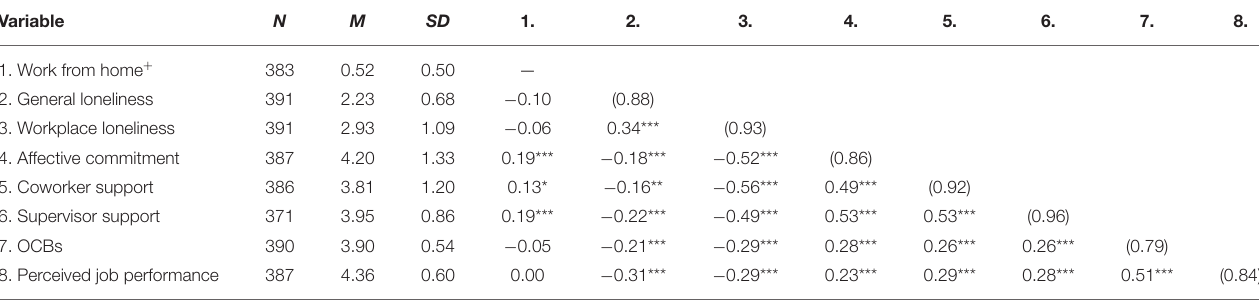
TABLE 2 | Descriptive statistics and bivariate correlations.